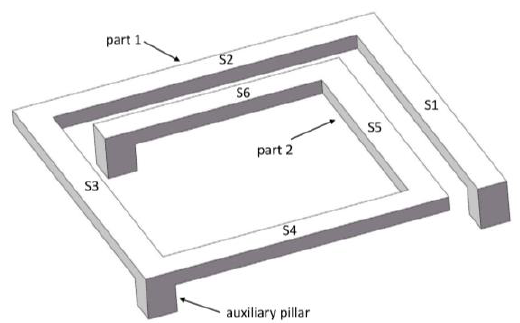
Figure 1. Schematic of the MEMS suspended inductor with auxiliary pillar.